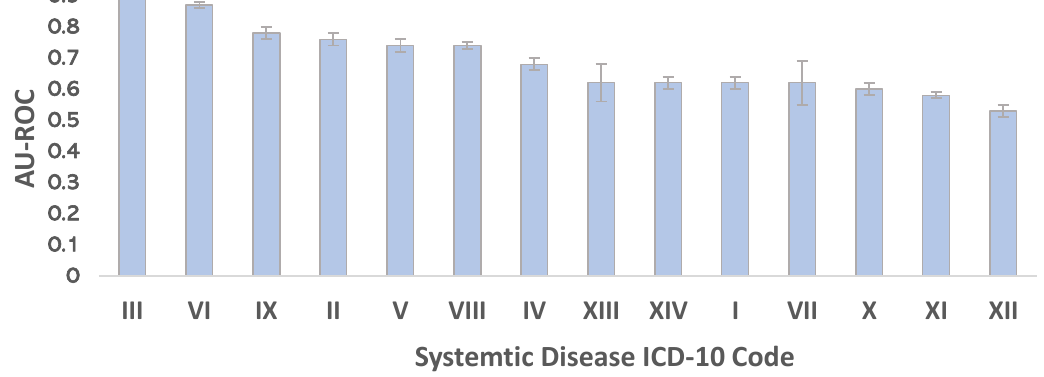
Figure 4. AU-ROCs of the 14 trained models. The results show the model has the best performance for the Chapters III, VI and IX.